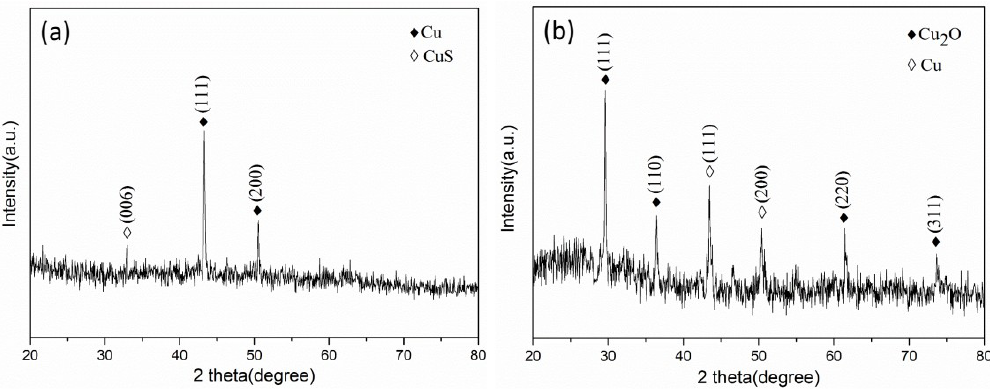
Figure 10. XRD patterns of samples under different storage conditions: ( a ) stored in absolute ethanol; ( b ) exposed to air for 24 h.